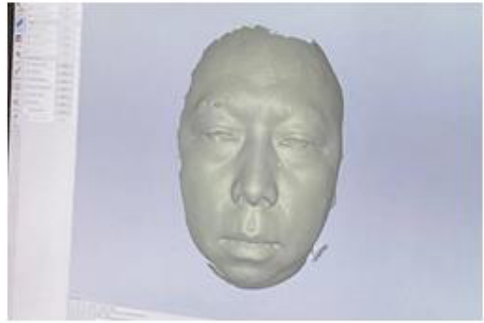
Figure 12. Laser scan image.